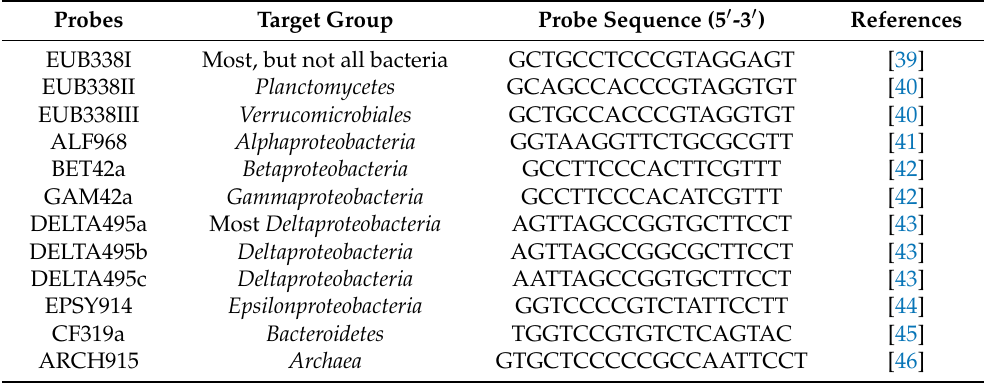
Table 2. HRP-labeled oligonucleotide probes used in this study. Probes EUB338I, EUB338II and EUB338III were equimolarly mixed together to obtain the EUB mix; probes DELTA495a, DELTA495b and DELTA495c were equimolarly mixed together to obtain the DELTA